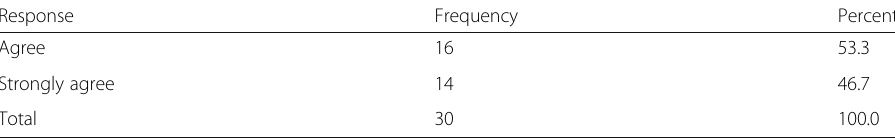
Table 11 Increased efficiency and speed of the crane Response Frequency Percent